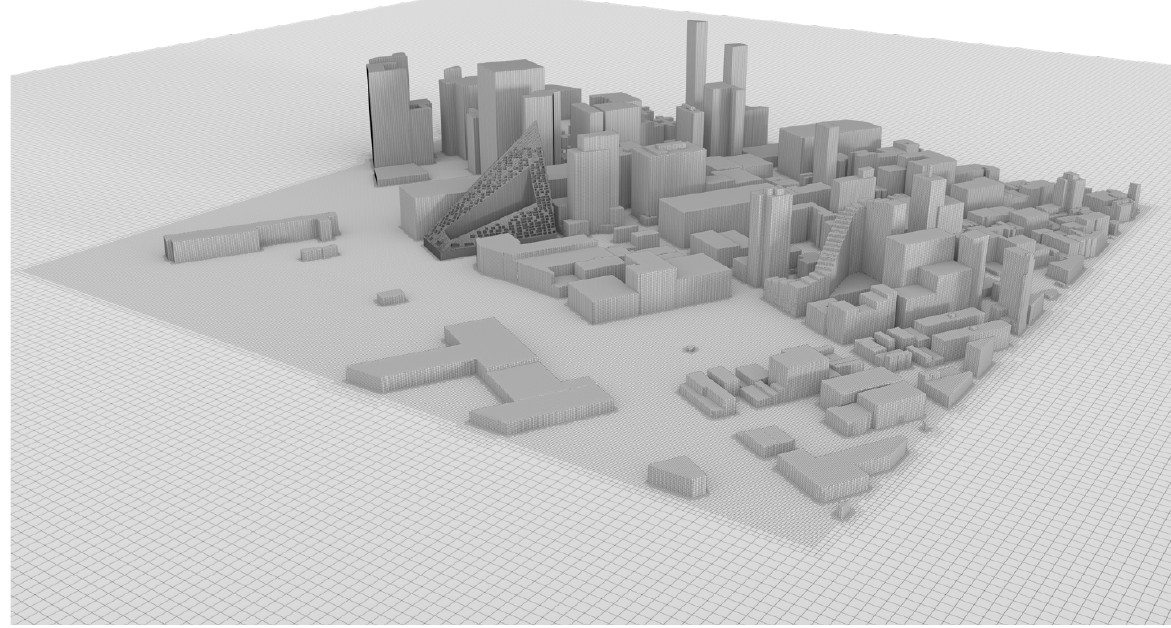
Fig. 6 Cityscape model domain & discretization (meshing). The model domain is 9840(W)x9840(D)x6560ft(H) and composed of 33.2 million cells. Additional refinement is provided in the regions of interest (i.e., around the buildings and ground